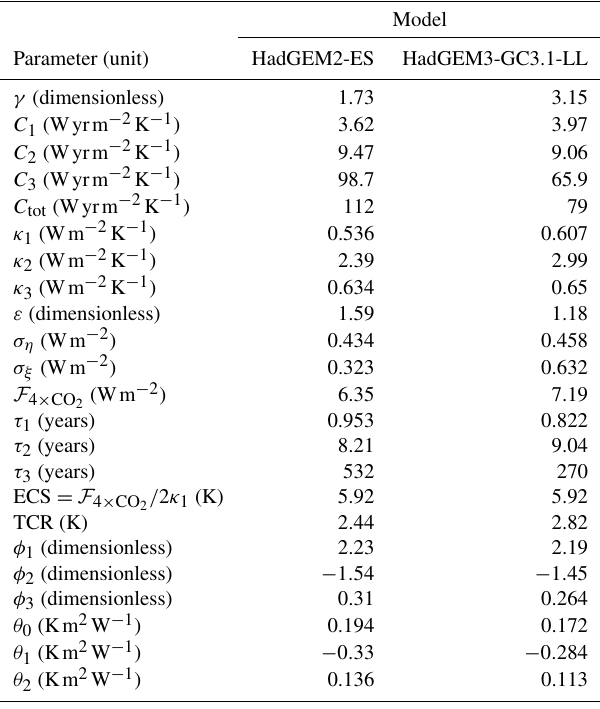
Table 1. Maximum-likelihood parameter estimates. For descrip- tions of all model parameters, see Table 1 of Cummins et al. (2020). Note that parameters γ and σ η are not used in this study. The val- ues of ECS and TCR in this table are derived directly from the box models’ physical